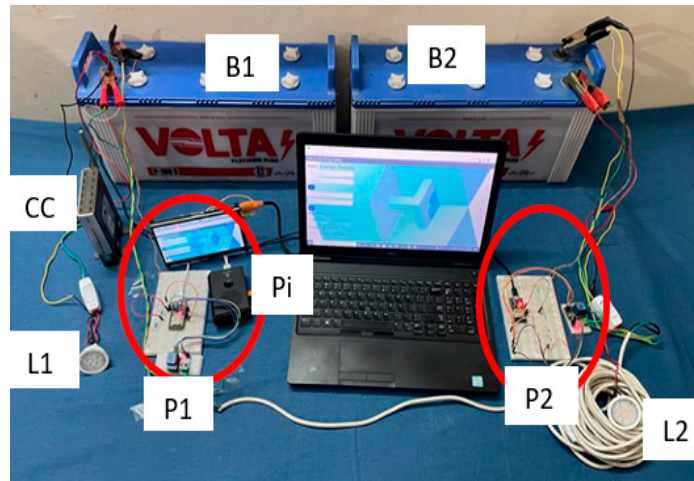
Figure 9. Experimental setup for the proposed P2P energy trading system .